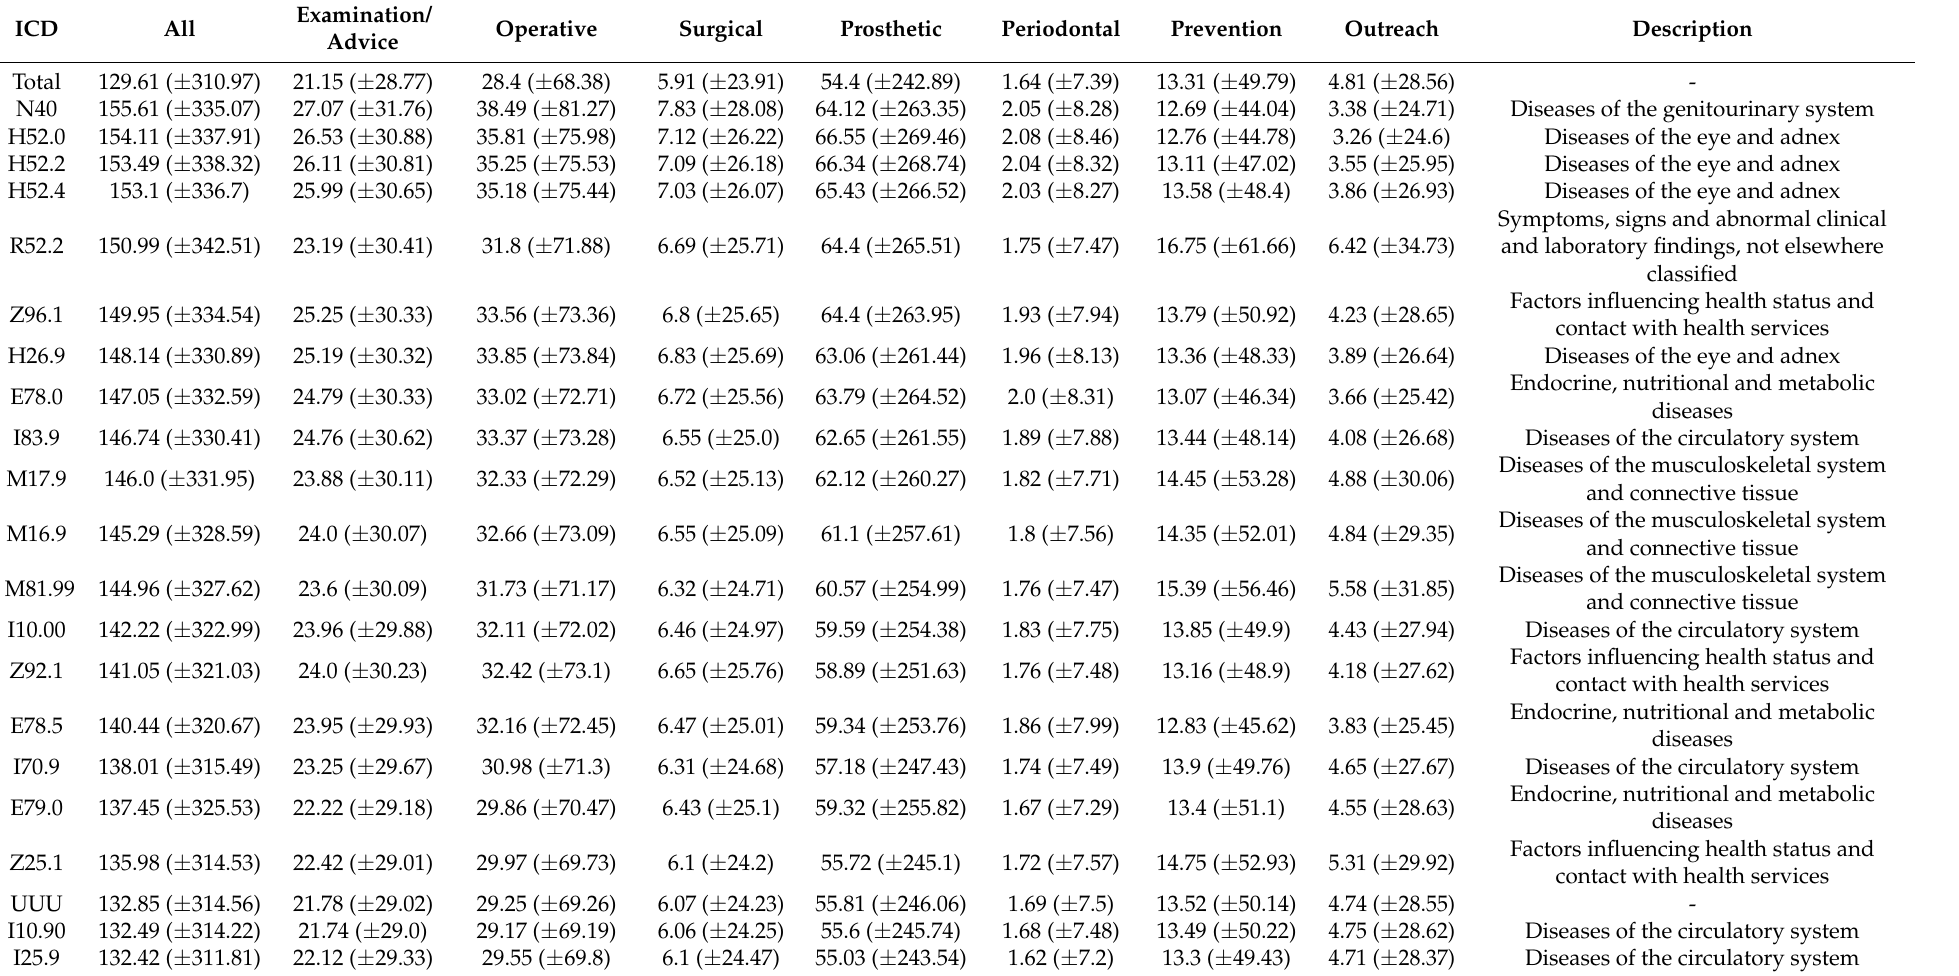
Table 2. Costs for dental services for the very old in Northeast Germany according to International Disease Classification (ICD-10, German Modification) codes. All and service-specific mean ( ± SD) costs are shown for the total population and the population with specific ICD-10